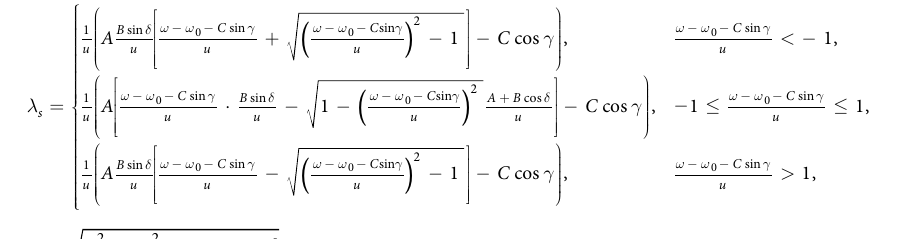
where of the field when its frequency mismatch falls in a certain range (Fig. 4). For attractive mean-fields, active hub-driven desynchronization is observed for positive frequency mismatches ( ω ω − > 0 natural frequency of the hub). Vice versa, negative mismatches can drive synchronization in the presence of repulsive mean-field.